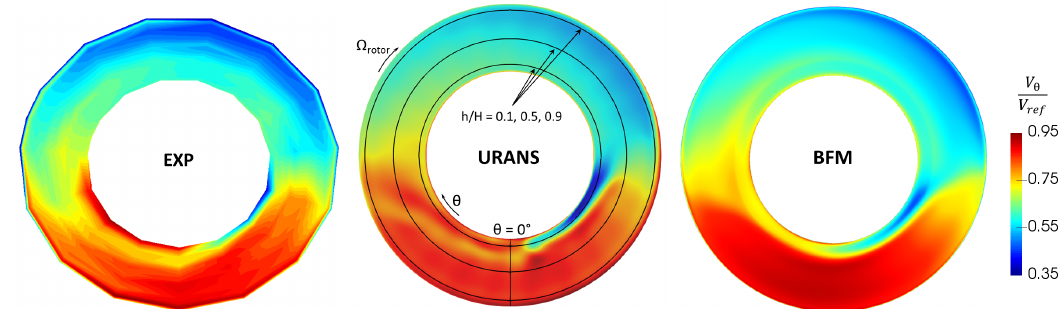
Figure 14. Absolute tangential velocity field in Section 3.